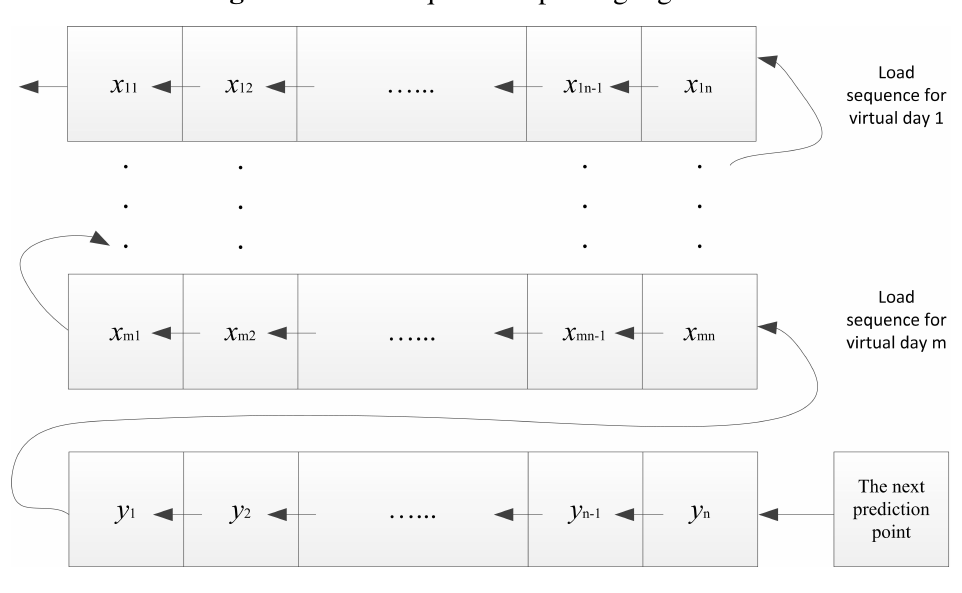
Figure 1. Load sequences updating